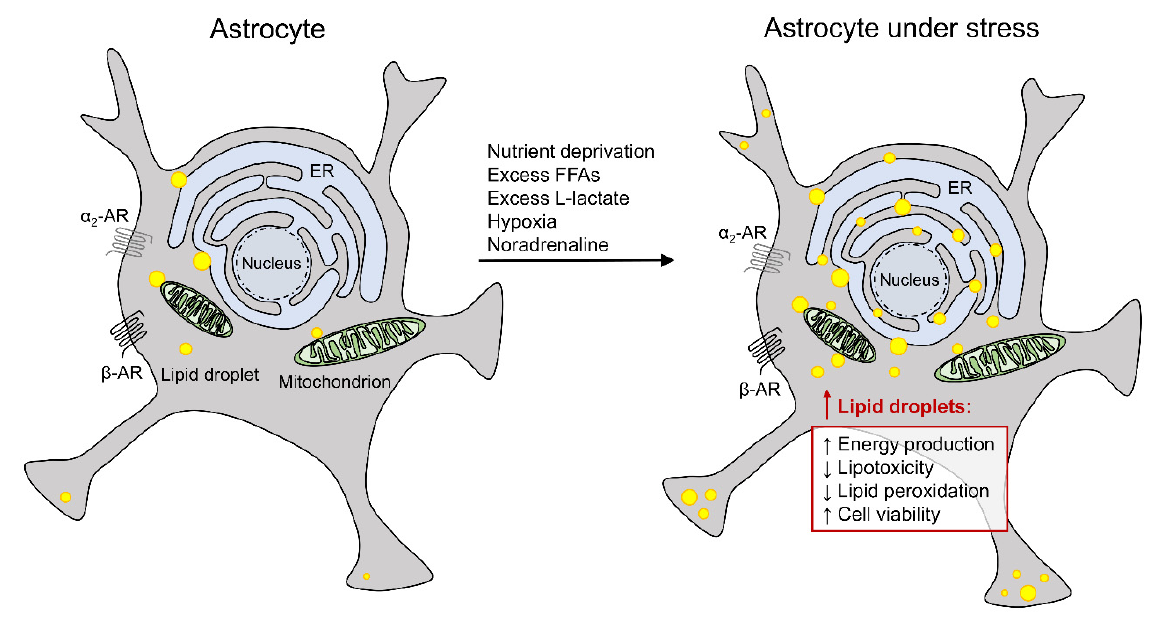
Figure 2. Astrocytes under stress accumulate lipid droplets. Most lipid droplets in astrocytes are in contact with or in close proximity to mitochondria and the endoplasmic reticulum (ER). Metabolic stress (nutrient deprivation, excess free fatty acids [FFAs] or L-lactate), hypoxic stress, and noradrenaline, which activates the CNS stress response via activation of α 2 - and β -adrenergic receptors (ARs), increase the accumulation of lipid droplets in astrocytes. Accumulation of lipids in LDs in stressed cells promotes astrocyte energy production via mitochondrial β -oxidation and prevents FFA-induced lipotoxicity and ROS-mediated membrane lipid peroxidation, which increases the viability of cells under stress (adapted from Smoli č et al.